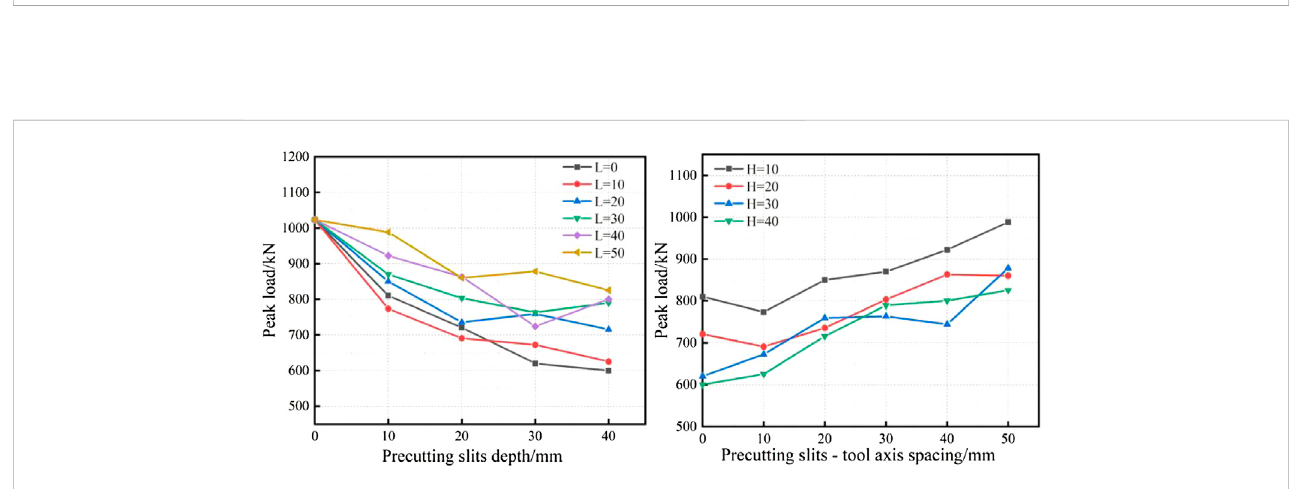
Figure 13A, with the same con fi ning pressure, as the precutting slit